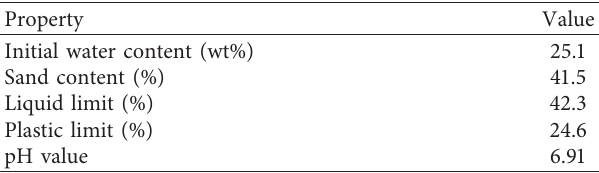
Table 3: Particle size distribution of the waste sediment. Particle size (mm)